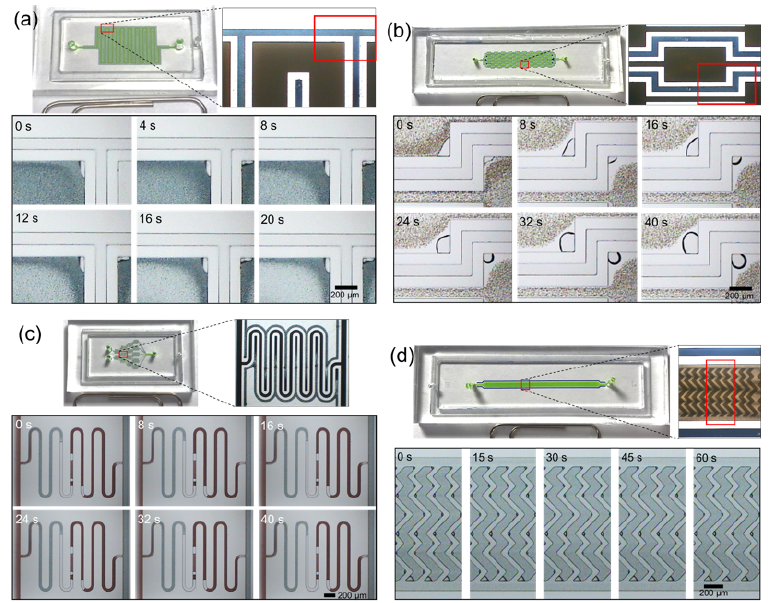
Figure 5. Sequential photographs showing air bubbles trapped in ( a ) a meandering microchannel, ( b ) a microvortex device, ( c ) a gradient micromixer and ( d ) a herringbone micromixer, fabricated by the conventional PDMS imprinting method using glass substrate.